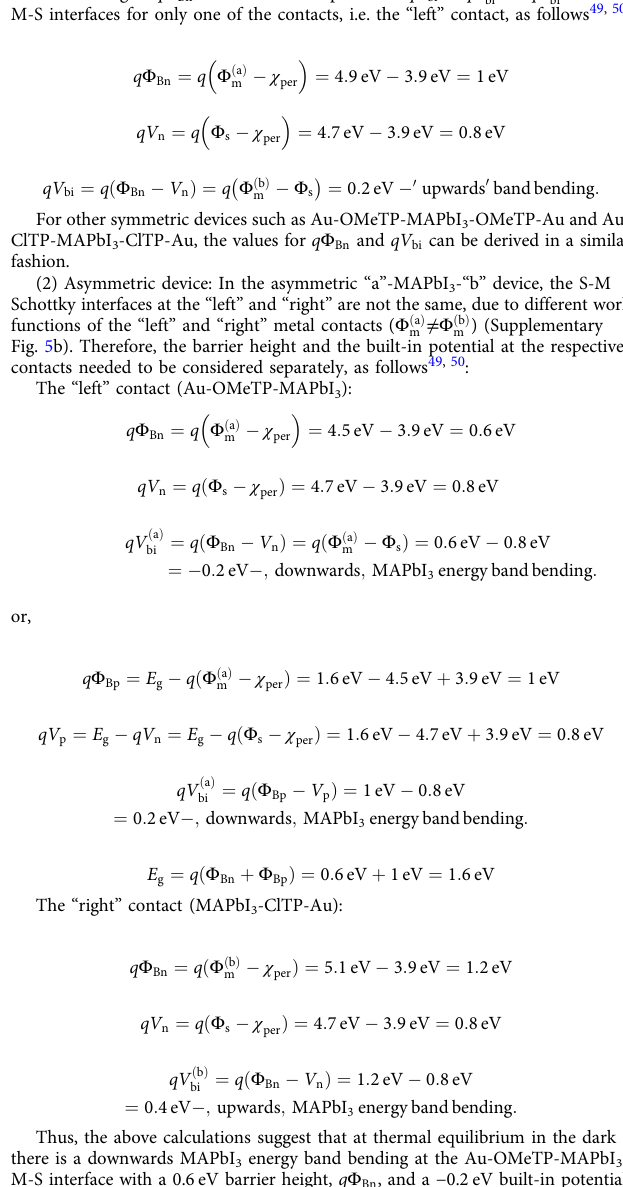
(Supplementary Fig. 13a). The best fi t in respect to peak-to-valley percentage variation of the PC pro fi le (Supplementary Fig. 13b) was chosen to be the L d value that corresponds to the experimental conditions presented here. Evaluation of the energy band diagrams for symmetric and asymmetric device constructs at thermal equilibrium in the dark . For the construction of the band diagrams of the symmetric and asymmetric devices, the values of the band gap of MAPbI 3 , E g = 1.6 eV, the electron af fi nity of MAPbI 3 , q χ per = 3.9 eV, and the work function of MAPbI 3 , q Φ s = 4.7eV, were taken from the literature 47, 48 . The work functions of pristine gold (Au), OMeTP-modi fi ed ( “ a ” ) and ClTP-modi fi ed ( “ b ”